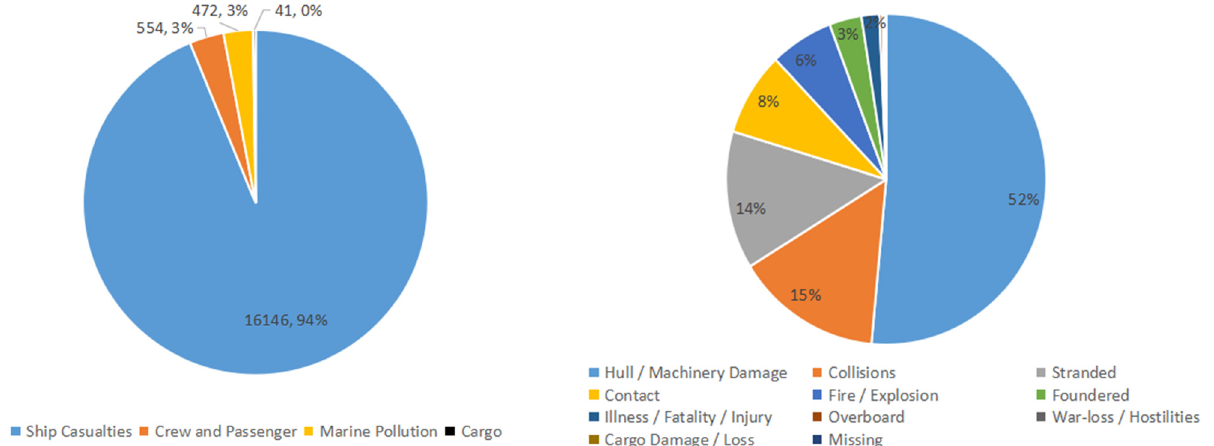
Figure 15. The main accident type and cause from the IHS database in 2011–2021.